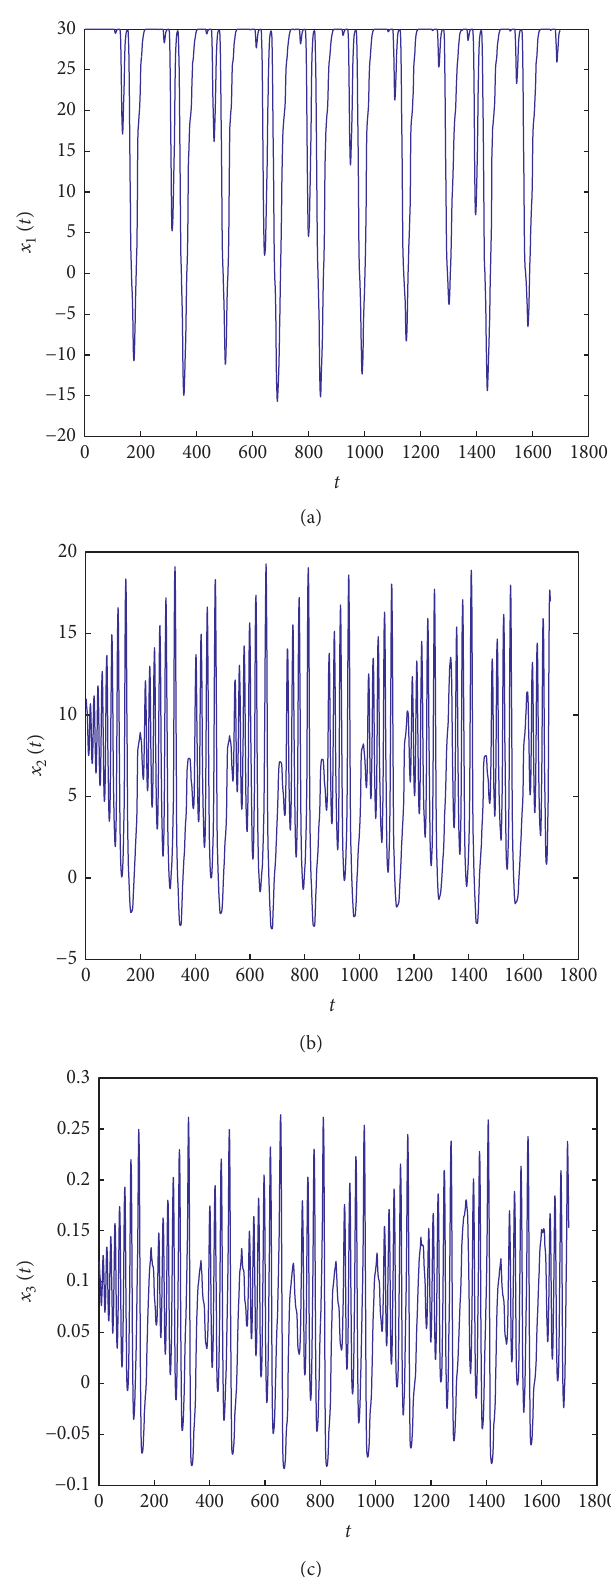
Figure 5: Trajectory components of system (1) ( x b 31 � 0.01, b 33 �